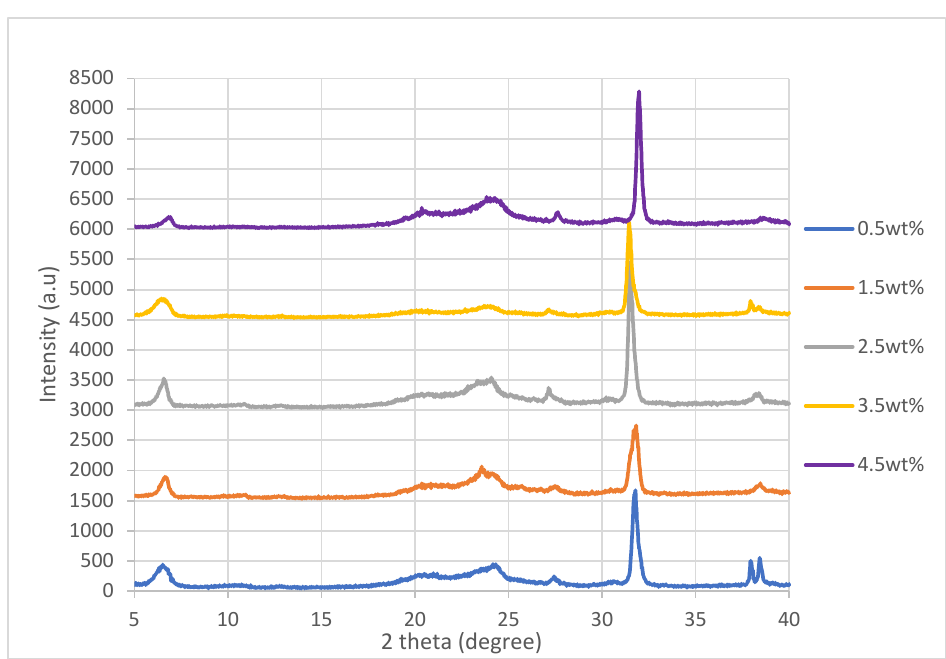
Figure 7. XRD Spectra of Nylon 610 Nanocomposites with Untreated Graphite Nanosheets.